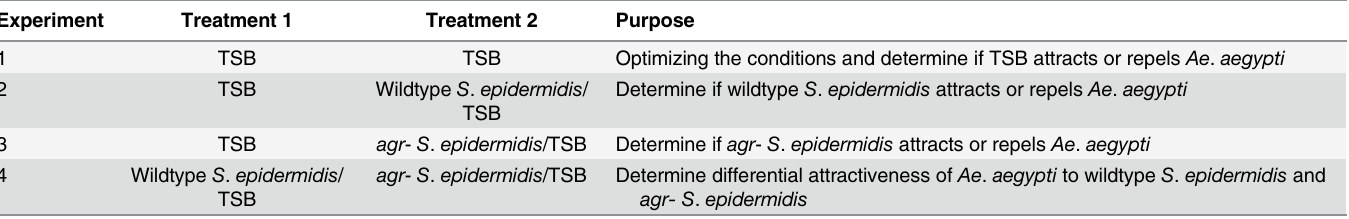
Table 5. Treatments in experiments examining female adult 5-8-d old Ae . aegypti mosquito responses to blood-feeders with different microbial treatments in 82 cm x 45 cm x 52 cm Plexiglas cage during 15-minute trials in a laboratory at approximately 25°C and 80%